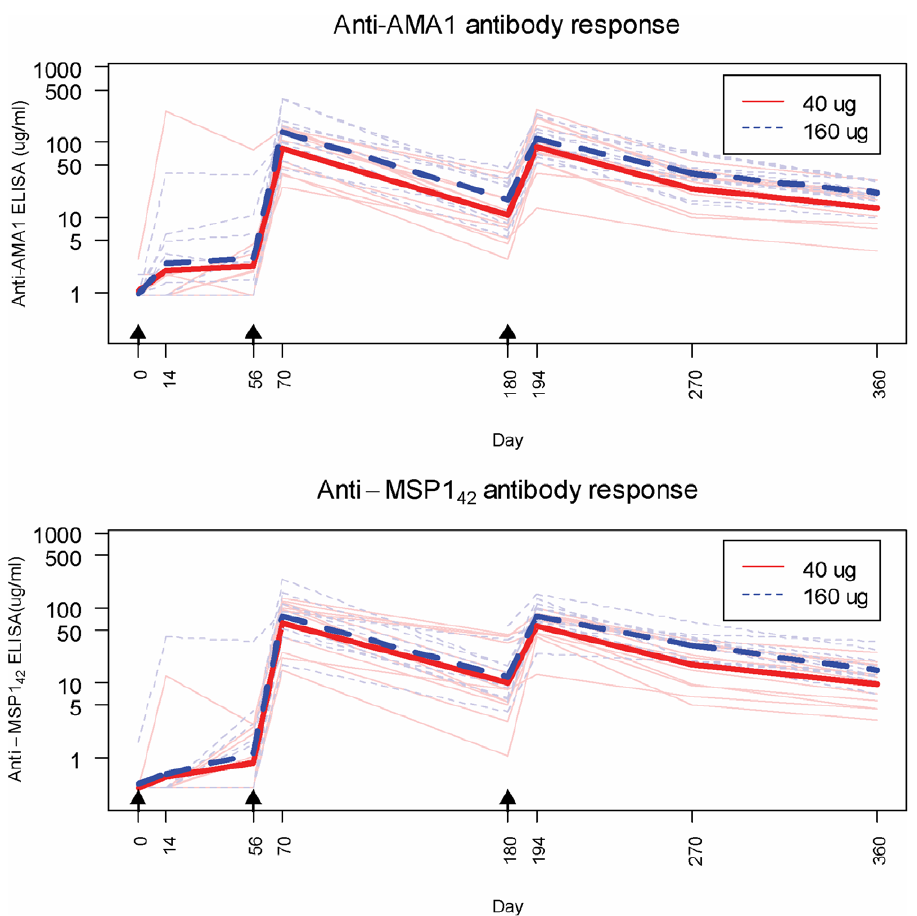
Figure 4. Antibody responses shown are the arithmetic mean of the FVO and 3D7 responses for each antigen for all volunteers who received all 3 vaccines and were not excluded per protocol (n=23). Thicker lines show the geometric mean response; arrows indicate vaccinations. Mann-Whitney tests with Hodges-Lehmann confidence intervals were done to compare responses in low versus high dose groups and 2 weeks after 2 nd and 3 rd vaccinations (days 70 and 194); although the 160 m g group had slightly higher geometric means (AMA1 D70: Fold Change=1.49 [95% CI 0.78, 2.92] p=0.28; AMA1 D194: FC=1.30 [0.68, 2.49] p=0.61;MSP1 D70: FC=1.18 [0.57,2.49] p=0.70; MSP1 D 194: FC=1.30 [0.85, 1.91]) p=0.21; differences were not significant at the 0.05